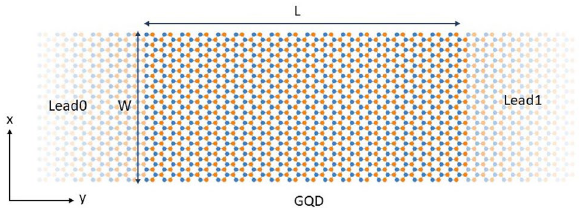
Figure 1. The schematic view of the armchair graphene nanoribbon system. The linear sizes of the rectangular GQD are defined as W carbon distance. The numbers M , N are integers.